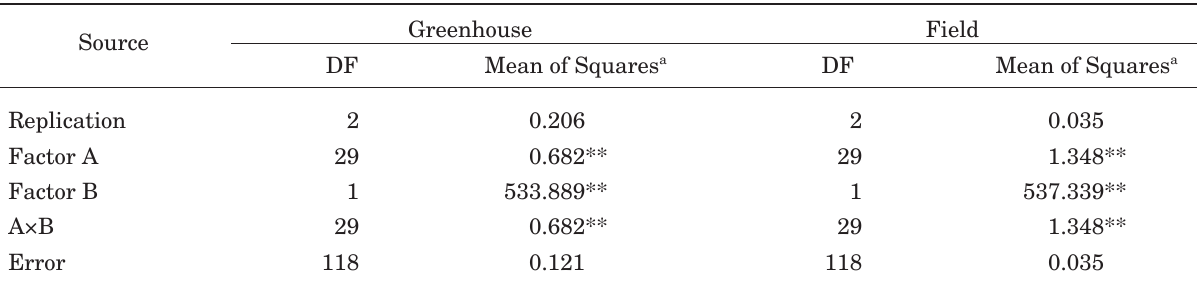
Table 2. Analysis of variance in greenhouse and field evolutionary experiments for common bean cultivar/lines resistance against common bacterial blight. Common bean cultivar/lines were planted in randomized complete blocks and data were obtained from means of 9 plants (3 plants per each